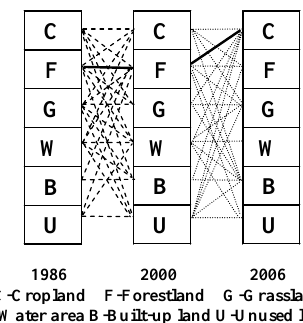
Figure 1. All possible trajectories of land use